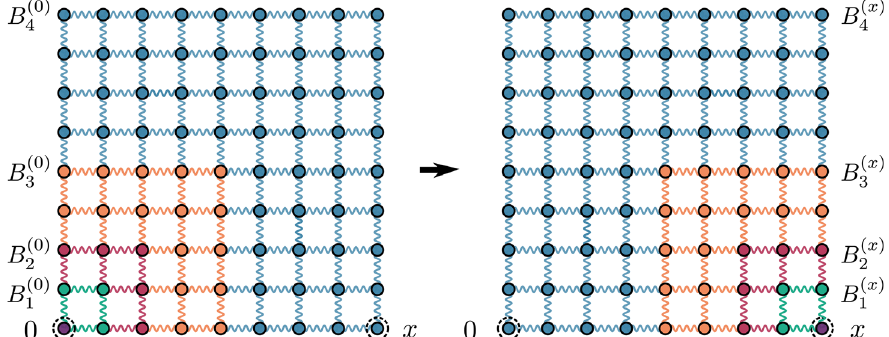
FIG. 3. An illustration of our single-particle state-transfer protocol in d ¼ 2 dimensions. Through four steps, we redistribute a particle 0 Þ ð 0 Þ ð 0 Þ ð 0 Þ initially at 0 to the square B ð 1 , then to B 2 and B 3 , and finally to B 4 , each time doubling the size of the region sharing the particle. We use different colors to mark the additional sites that the particle spreads to in different steps. We then reverse the process to concentrate the particle on the target site x and thereby achieve a perfect state transfer. The protocol is enhanced by the volume r d of the squares, with r being a typical size of the squares. This enhancement offsets the penalty 1 =r α due to the power-law constraint, resulting in a superlinear state-transfer protocol when α < d þ 1